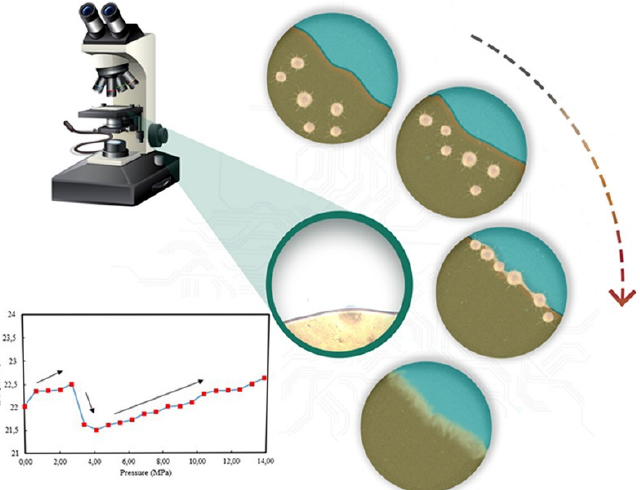
Figure 25. Asphaltenes surface behavior at oil–water interface. Reprinted with permission from Ref.